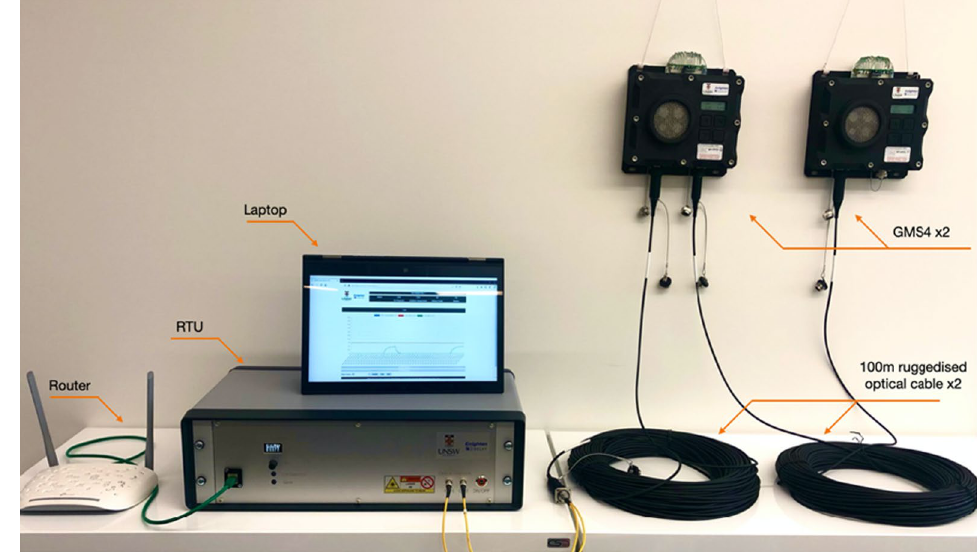
Fig. 5 Certified intrinsically safe, optically powered gas monitoring system with daisy-chained